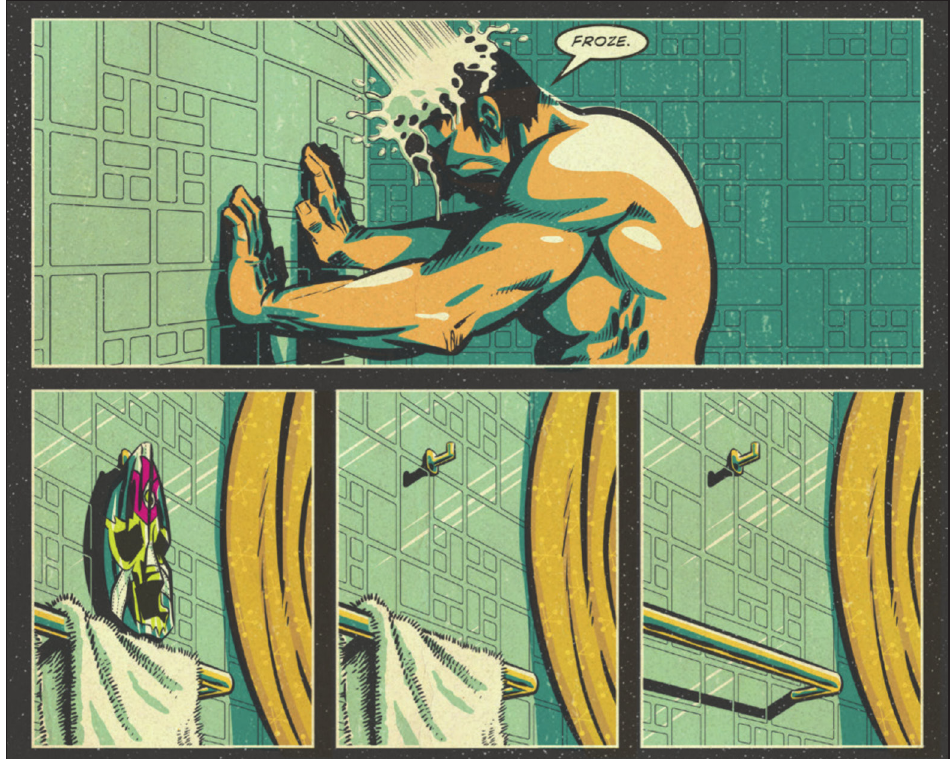
Figure 3 The only moment in which the protagonist is shown without wearing his mask in J. Gonzo’s La Mano del Destino Collected Edition